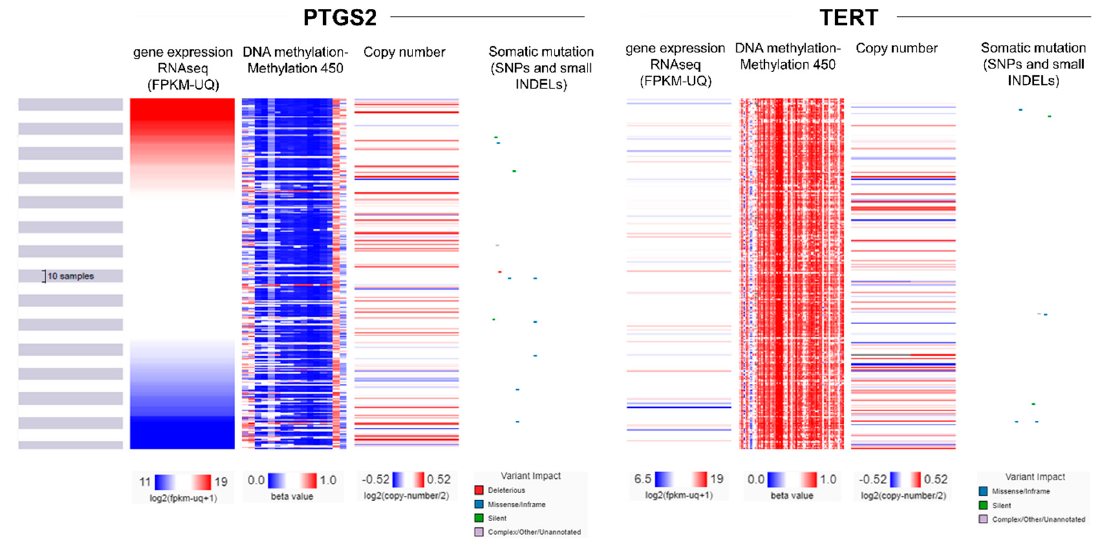
Figure 7. A multi-omics analysis revealed that the promoter of PTGS2 is broadly hypomethylated, whereas that of TERT is extensively hypermethylated in colorectal cancer. Nevertheless, no significant association was found between DNA methylation, copy number aberrations, or somatic mutations (SNPs and small INDELs) and the expression pattern of PTGS2 or TERT genes.